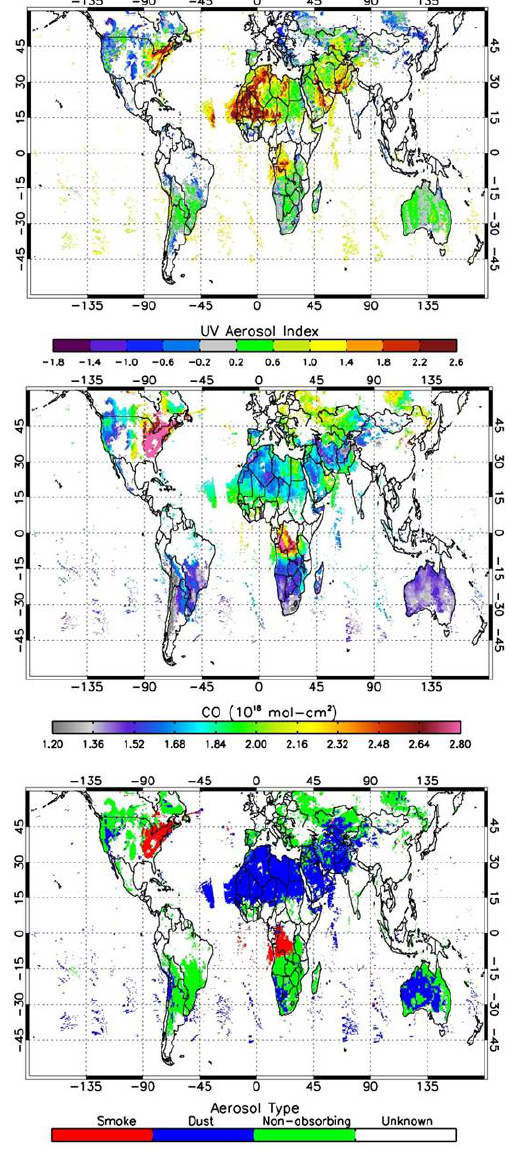
Fig. 2. OMAERUV Aerosol Index on 7 July 2006 (top), AIRS CO amounts (middle), and aerosol type classification